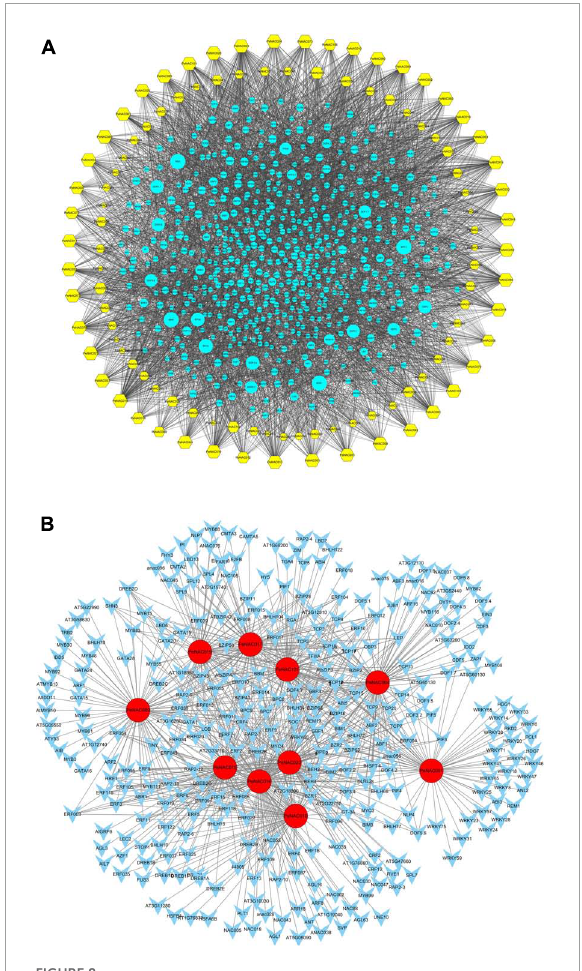
FIGURE8 The putative transcription factor regulatory network analysis of PeNAC genes. (A) Turquoise circular nodes represent transcription factors; yellow hexagonal nodes represent PeNAC genes and node size represents the degree of interaction between nodes based on degree value. (B) The top 10 highly enriched and targeted PeNAC genes are shown, darker the color shows highly enriched. Transcriptional factors were predicted by PTRM online program and a regulatory network was constructed using the Cytoscape 3.9